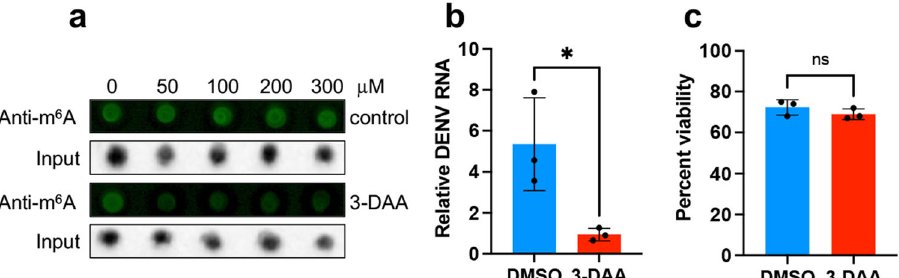
Fig. 4 3-Deazaadenosine, an inhibitor of m 6 A, reduces DENV replication in Ae. aegypti cells. a Con fi rmation of the effect of 3-DAA on inhibition of m 6 A modi fi cation in Aag2 cells. Total RNA from 3-DAA treated Aag2 and control cells (DMSO treated) were extracted and subjected to a dot blot assay using a speci fi c anti-m 6 A antibody. The input RNAs were directly stained with ethidium bromide. b Inhibition of DENV replication by 3-DAA. Aag2 cells treated with 100 μ M 3-DAA or DMSO were infected with DENV 72h after treatment with 3-DAA. Cells were collected at 72hpi for quanti fi cation of DENV RNA by RT-